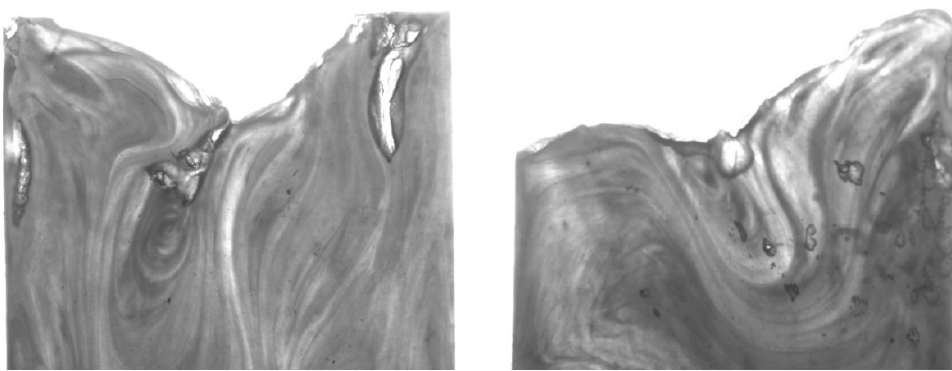
Figure 11. Test part 3 flow fronts with gas trapped within the parts.